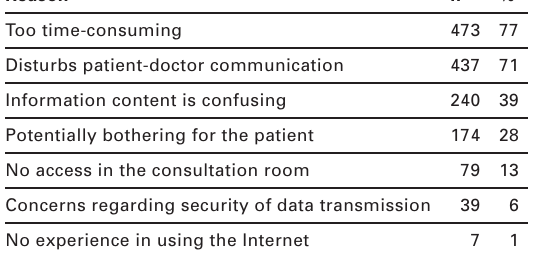
Information sources for handling of medical problems (n = 888).